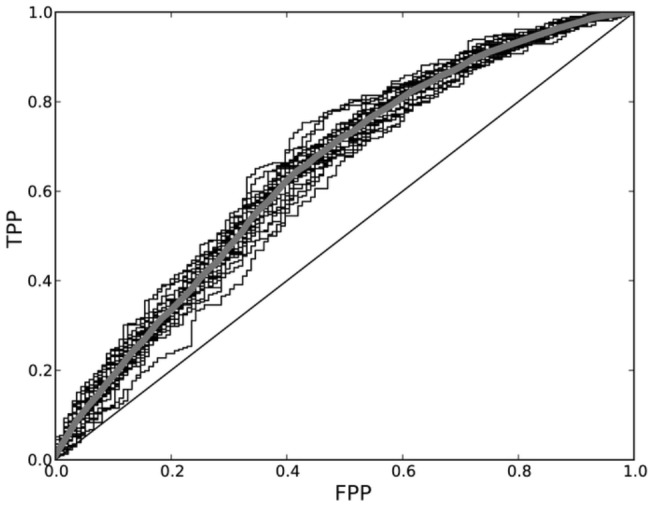
Cross-validation of the immunogenicity model.Two-thirds of the data were used for making the immunogenicity model (see methods) and one-third for cross-validation. The average ROC (thick grey line) of 25 of such cross-validations (thin lines) are plotted. The average AUC was 0.65.